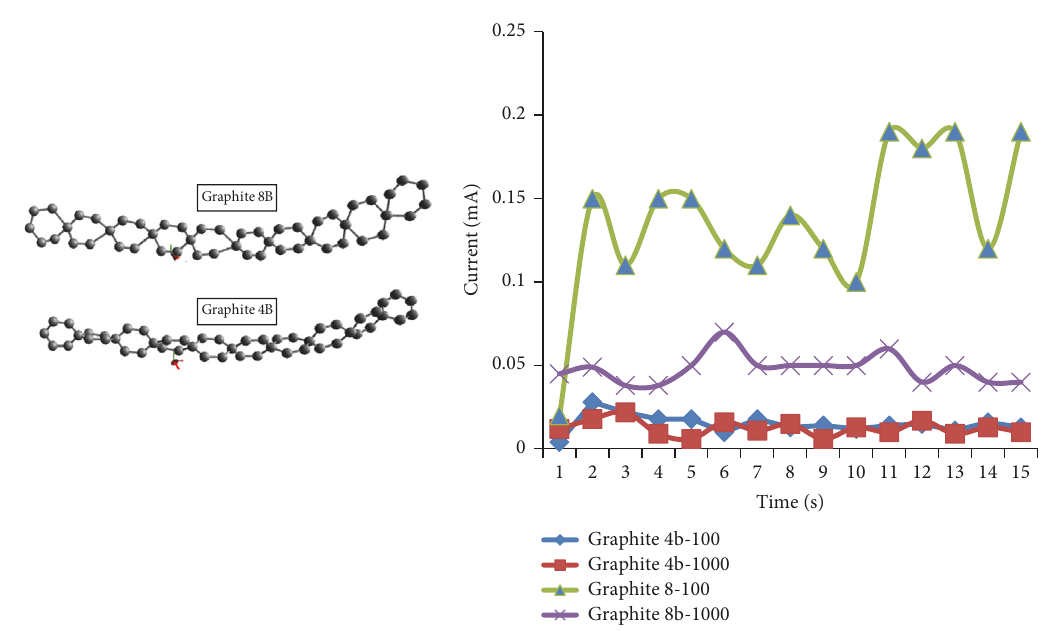
Figure 3: Graphite conductivity with a load of 100 and 1000 ohms.